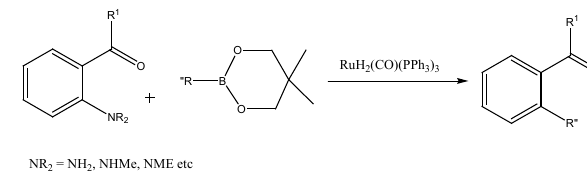
Scheme 3: Cleavage of C–N bonds in aniline derivatives on a ruthenium center [19,20].